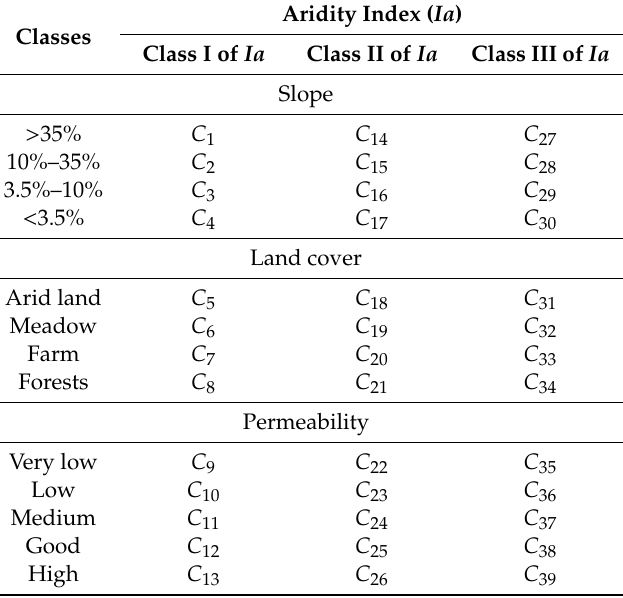
Table 3. Parameters of optimization for calibration of the Kennessey model. Aridity Index ( Ia Classes